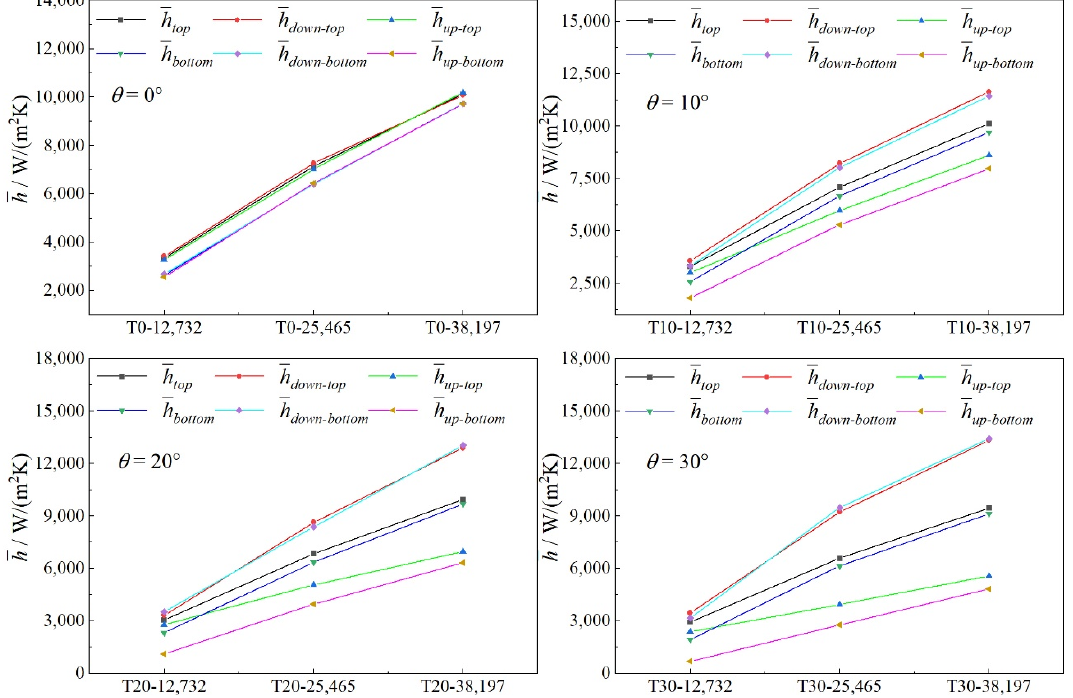
Figure 14. Comparison of the average heat transfer coefficient ( h ) between the downstream and upstream regions of steel tubes under different tilt angle. upstream regions of steel tubes under different tilt